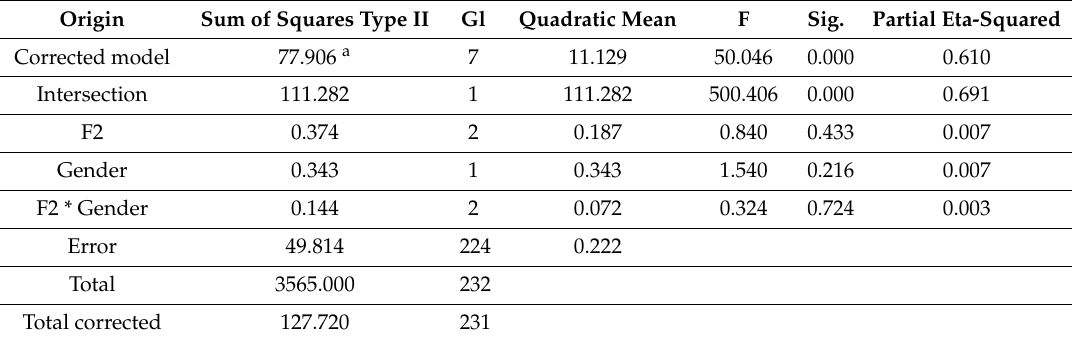
Table 8. Tests of the inter-subject e ff ects between F1 and F2 with covariable gender.